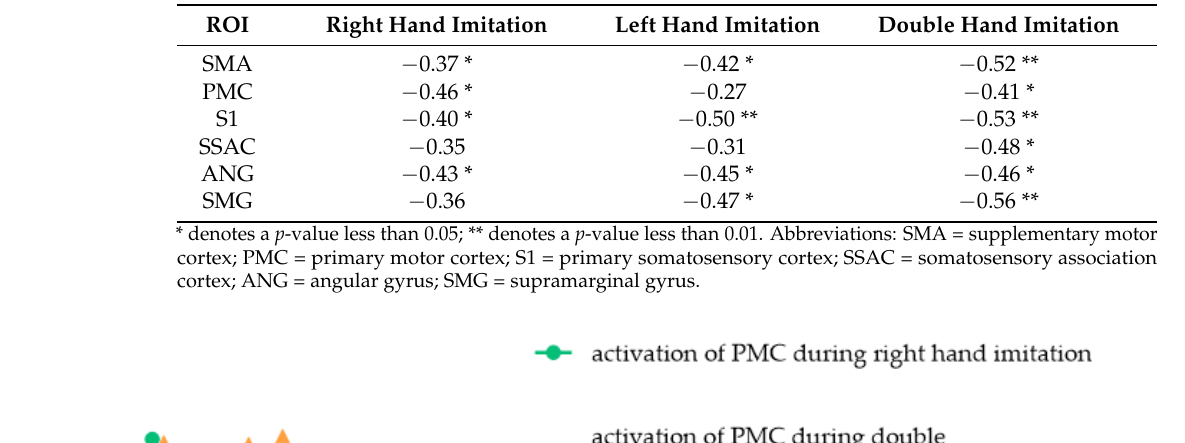
Table 3. Correlation between average imitation time and MNS activation in female students.